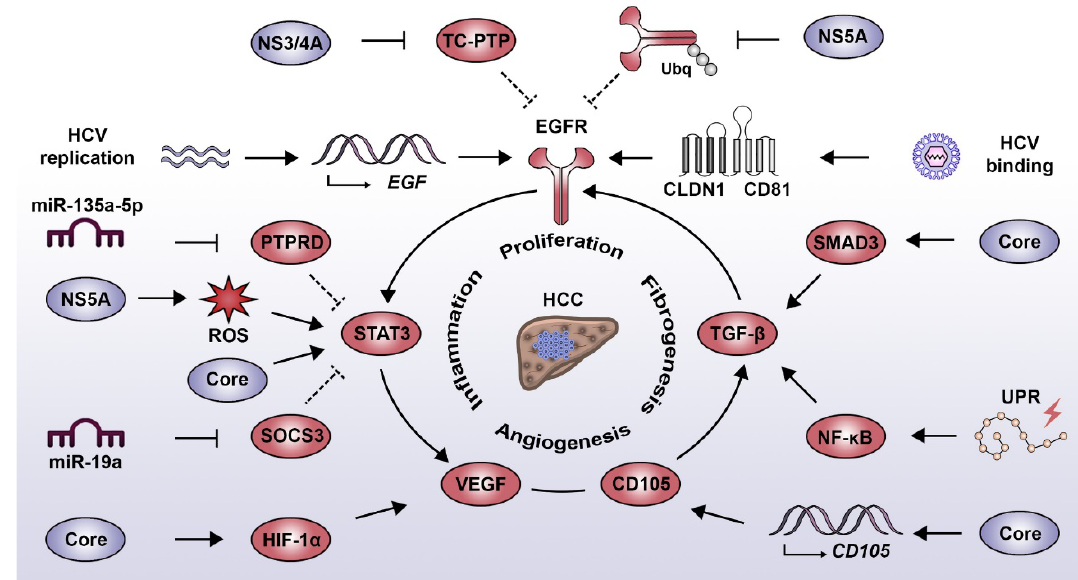
Figure 1. Interplay between HCV-induced oncogenic signaling pathways. EGF pathway: HCV binding to its entry receptor complex (i.e., CLDN1/CD81) induces EGFR phosphorylation. This is sustained by the action of NS3/4A and NS5A which negatively regulate the phosphatase TC-PTP and the process of EGFR degradation, respectively. Additionally, HCV replication has been linked to the increased expression of EGF and activation of the TGF- β pathway, both contributing to EGFR signaling. STAT3 pathway: STAT3 activation results from the direct action of the core protein and